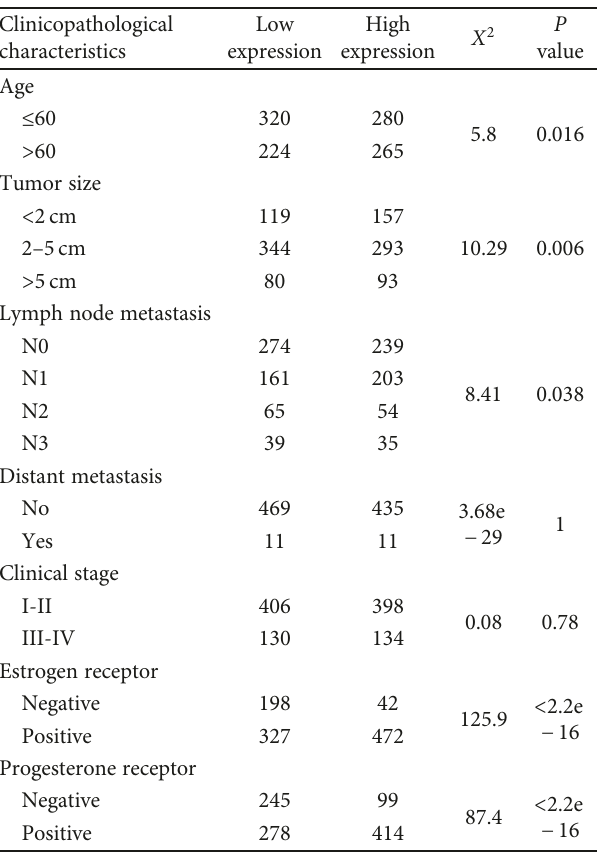
Table 1: The relationship between EIF3J-AS1 and clinicopathological features in the TCGA